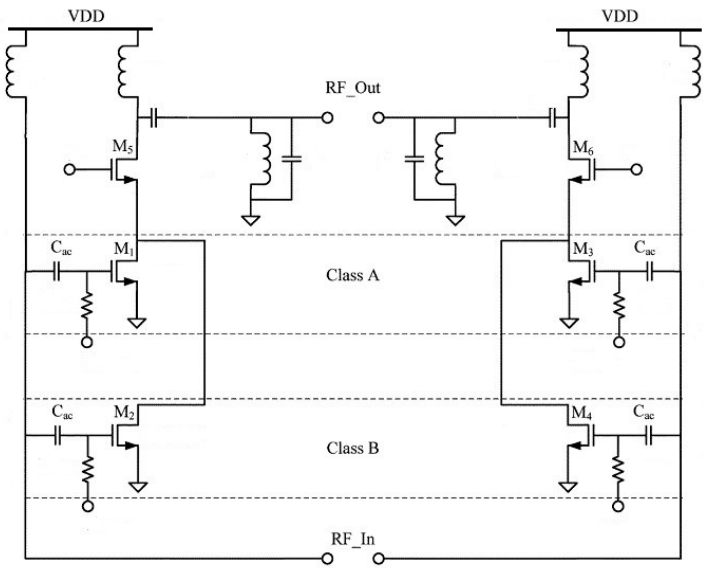
Figure 3. Circuit schematic for the CMOS parallel class-AB amplifier [33].